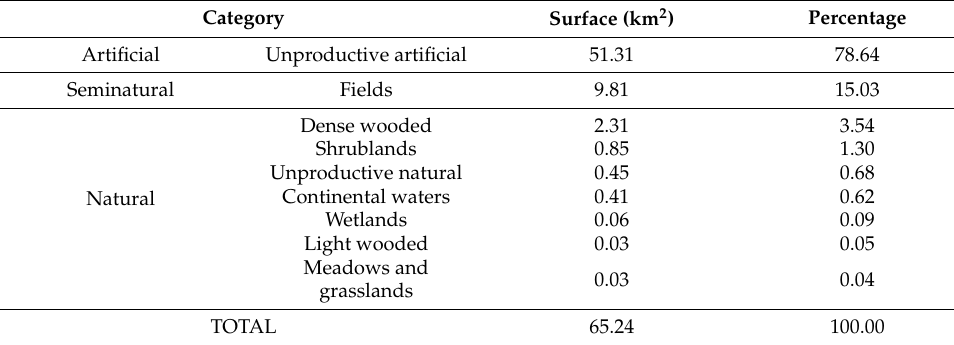
Figure 1. Location of the study area (Llobregat Delta, Spain) in the distribution range of Mauremys leprosa in the Mediterranean coast of the Iberian Peninsula (squares on top). Mainland-use categories of study area: dark gray: unproductive artificial; gray: semi-natural (essentially fields); pale gray: natural (wooded areas, wetlands, water bodies, etc.). The red dots represent our sampling stations: Ca l’Arana (CA), Cal Tet (CT), la Murtra (EB10), Bassa dels Pollancres (EB4), Braç de la Vidala (EB5), Riera de Sant Climent (EB6), Can Dimoni Gran (EB7), canal de la Bunyola 2 (EC4), canal de la Bunyola 1 (EC5), Llera Nova 1 (LL1), Llera Nova 2 (LL2), el Remolar (RE) and la Ricarda (RI). Table 1. Mainland-use categories and their occupied surface within the study area (Llobregat Delta, Spain). Natural landscape does not exceed 7% of total surface.